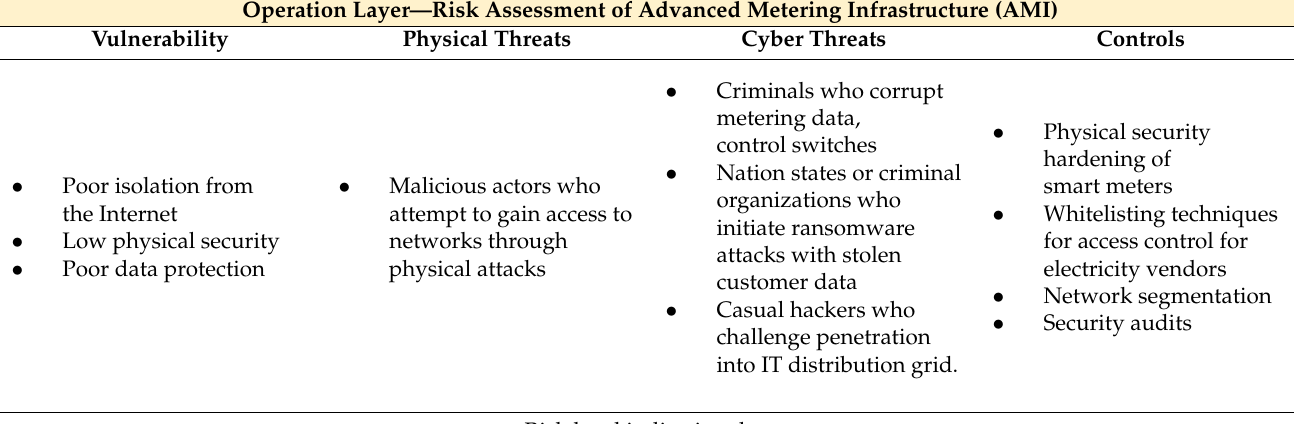
Table 14. Risk assessment of Advanced Metering Infrastructure